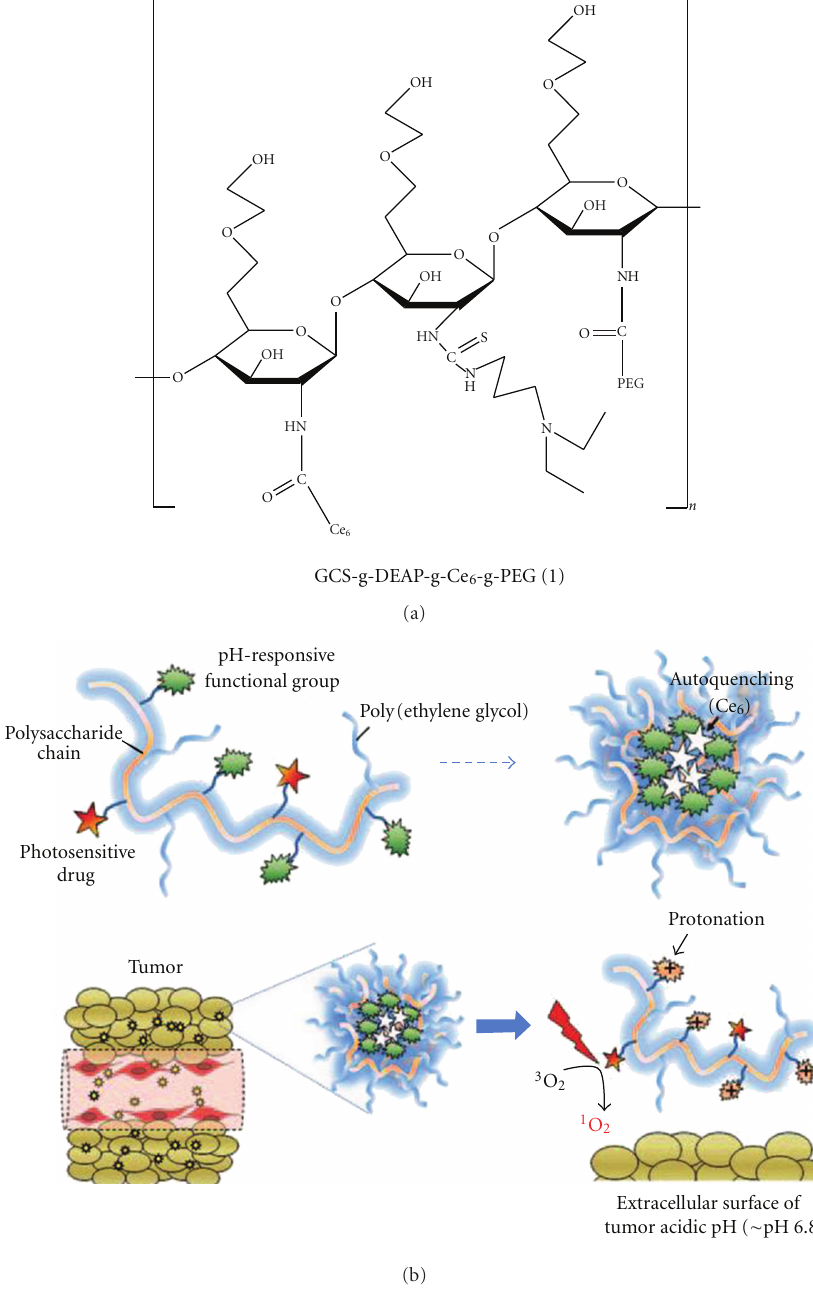
Figure 7: (a) Chemical structure of pH-sensitive polymeric carrier for PSs. (b) Schematic concept for a proposed polymeric carrier for PSs